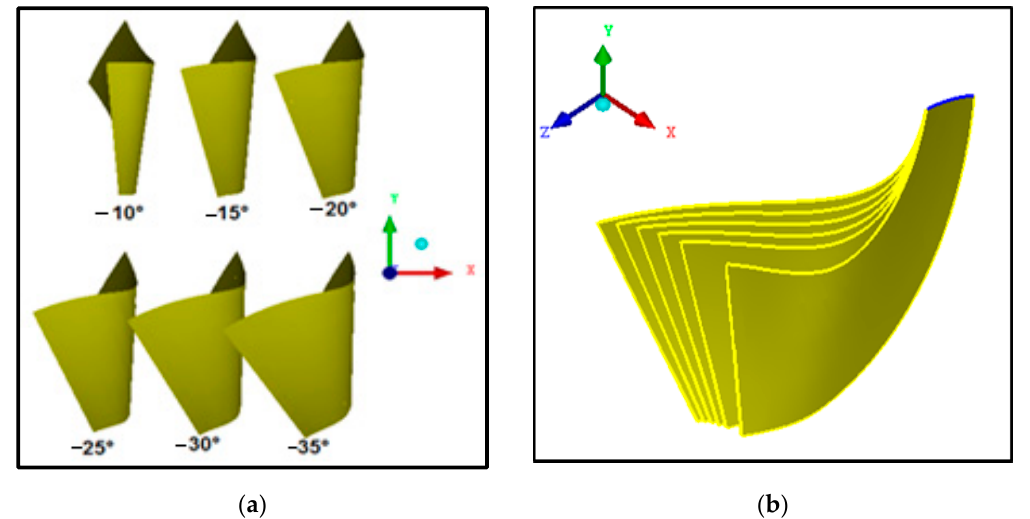
Figure 15. The suggested blade design: ( a ) geometrical forms view; ( b ) view of blade geometries comparison.